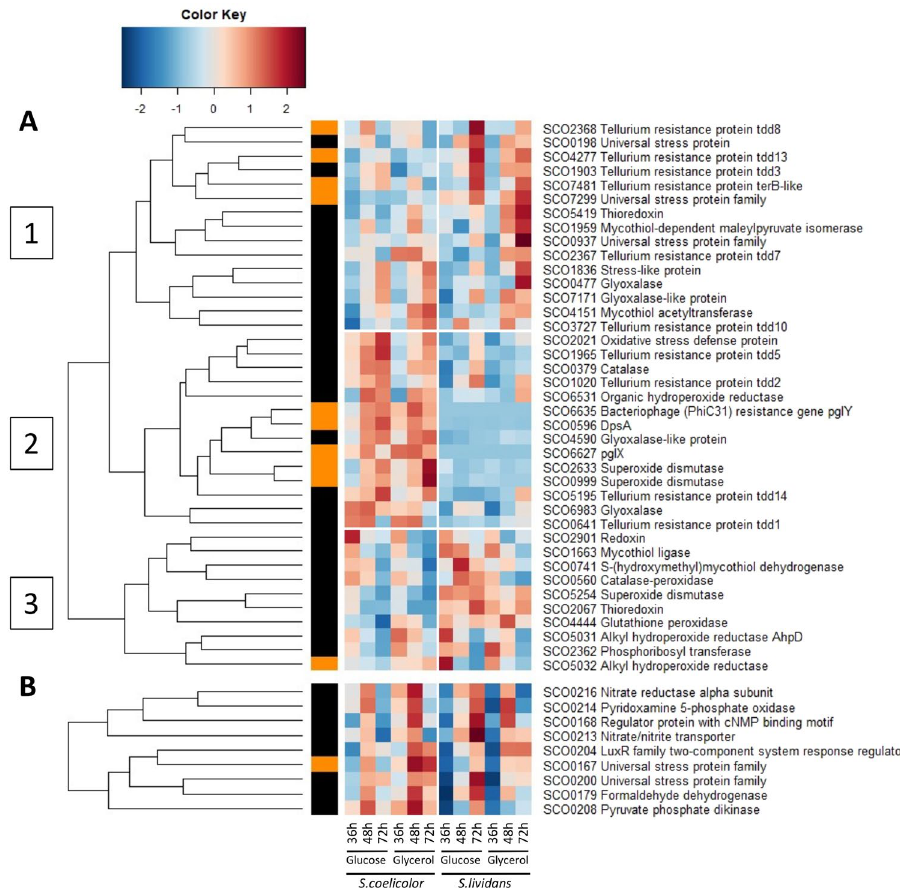
Figure 7. Independently generated heatmap representations of proteins involved in stress response and defense with significant abundance change (ANOVA, adjusted p value < 0.05) between S. coelicolor (M145) and S. lividans (TK24) with either glucose or glycerol as main carbon source, for 36, 48 and 72 h. General stress resistance proteins (clusters 1 to 3) (A) . Proteins belonging to the OsdR regulon (B) . Protein identifiers are indicated as SCO numbers for both strains and by predicted functions. The quantification methods are displayed in the vertical bar indicating proteins quantified by Spectral Counting (orange) or XIC